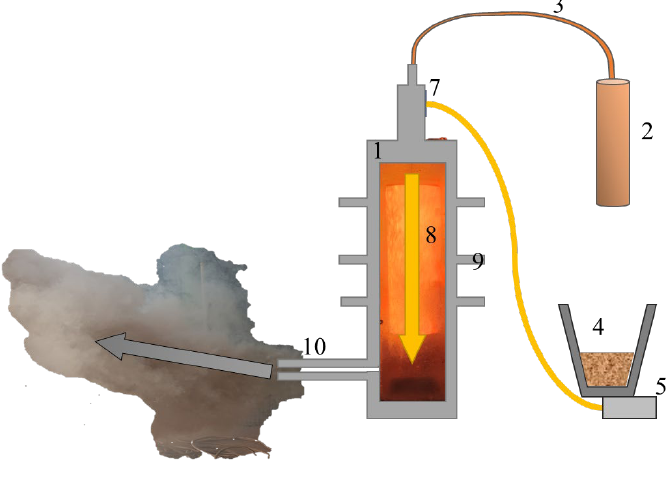
Fig. 1. Simplified schematic of the co-firing